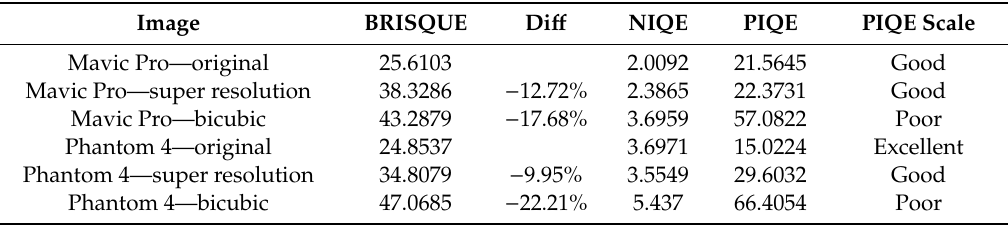
Table 2. Image quality metrics (IQM). BRISQUE: blind referenceless image spatial quality evaluator,